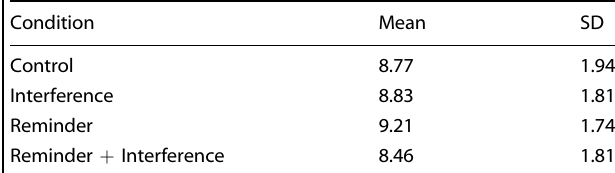
Table 7. Recognition accuracy mean and SD scores in Experiment